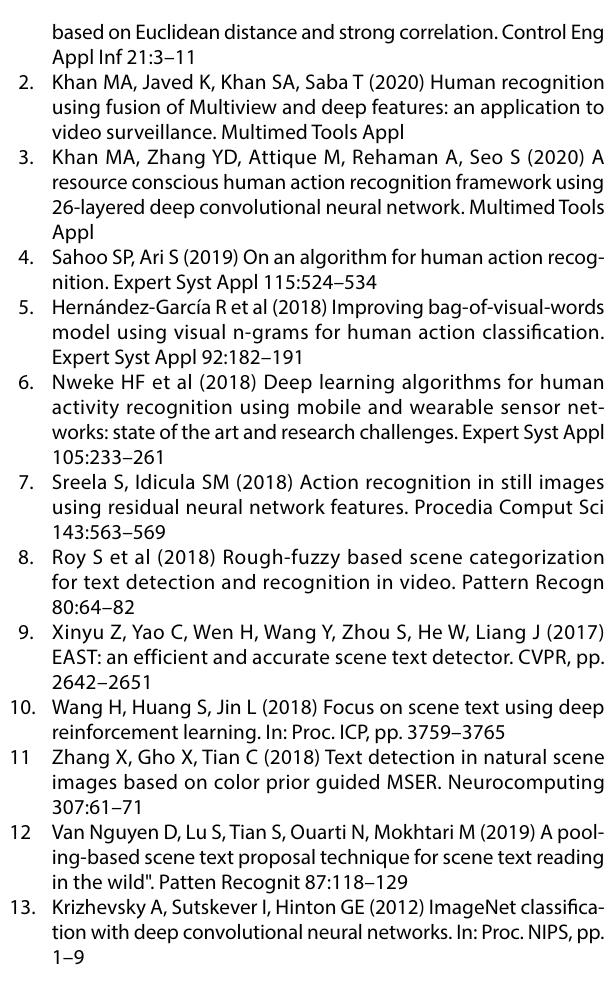
Fig. 13 Samples of unsuccessful classification results of the proposed approach on different datasets. Original Source: [42] and